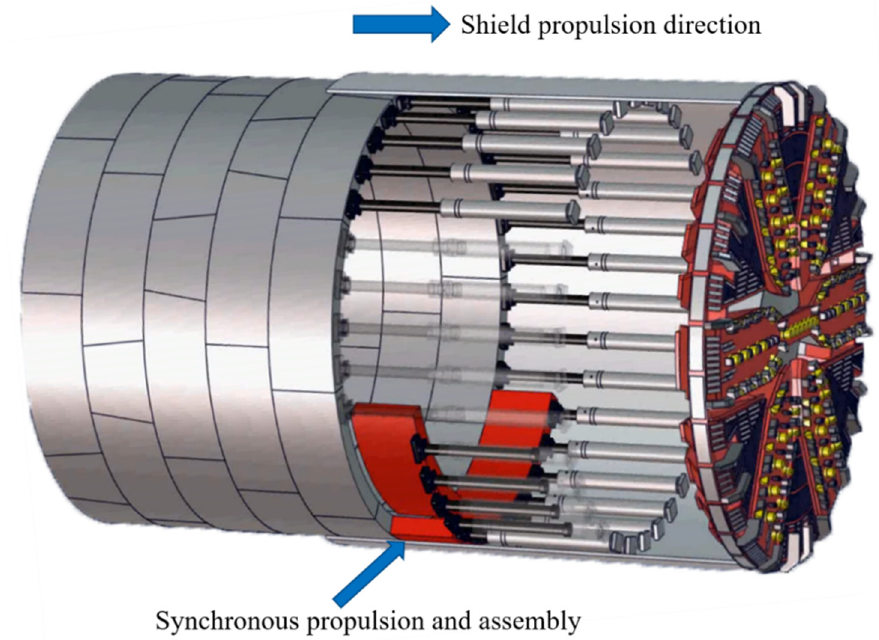
Figure 2. Schematic diagram of the synchronous propulsion and assembly method.